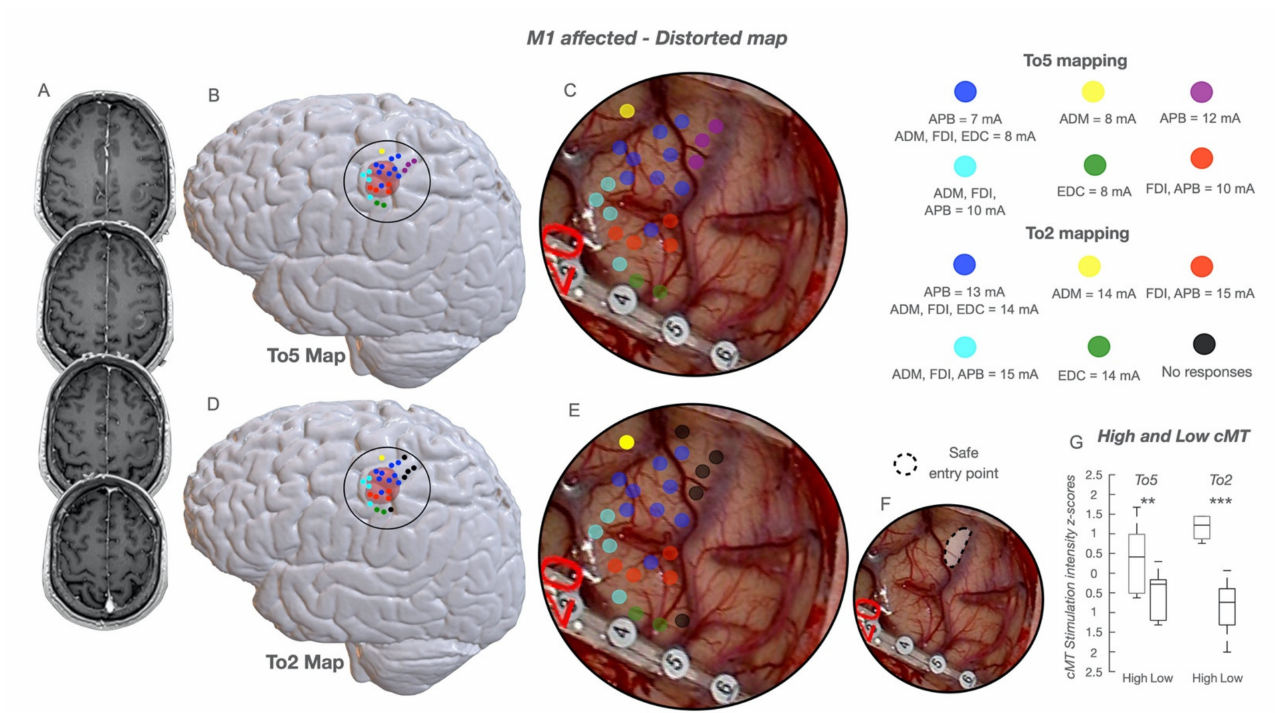
Figure 4. Distorted functional map in patients with M1 involved. The functional cortical map is presented in a case of glioma involving the hand-knob region in the dominant hemisphere; the lesion is visible in ( A ), sequential axial post GD T1 weighted images, as a well-defined patchy enhancing mass involving the hand-knob region of M1. The cortical area exposed (circle line), the sites stimulated with HF-To5 (colored dots) and the tumor area (pink volume) are reconstructed in an NMI space and shown in ( B ) (To5 Map). The cortical area exposed (circle line), the sites stimulated with HF-To2 (colored dots) and the tumor area are reconstructed in an NMI space and shown in ( D ) (To2 Map). The picture of the intraoperative field along with the location of the stimulated sites (colored dots) by using HF-To5 superimposed to the surgical field is shown in ( C ); a cortical strip is crossing the inferior part of the motor cortex (at the inferior border of the hand-knob region); HF-To5 evoked MEPs at variable cMT (ranging between 7 and 12 mA) without a functional segregation between the anterior and posterior regions. The picture of the intraoperative field along with the location of the stimulated sites (colored dots) by using HF-To2 superimposed to the surgical field is shown in ( E ); HF-To2 evoked MEPs at variable cMT (ranging between 13 and 15 mA) without a functional segregation between the anterior and posterior regions; however, a region in which no MEPs were evoked at a current intensity of 20 mA was detected in the superior and posterior regions of the motor cortex (no response, black dots); this region was used as a safe entry zone in which to perform the corticectomy and to start the resection (shown in ( F ) as a dotted circle line, safe entry point). In “distorted-map” patients, in the absence of an anterior and posterior subdivision, the highest and lowest cMT in each patient obtained with HF-To5 vs. HF-To2 were selected ( G ); the values were then normalized within the subject ( Z -score) to assess the preservation, despite the subversion of the architecture, of the two different functional components. Cumulative cMT are expressed as 25–75% median (rectangle) and 9–91% (edge of the box); ** p < 0.01; *** p <